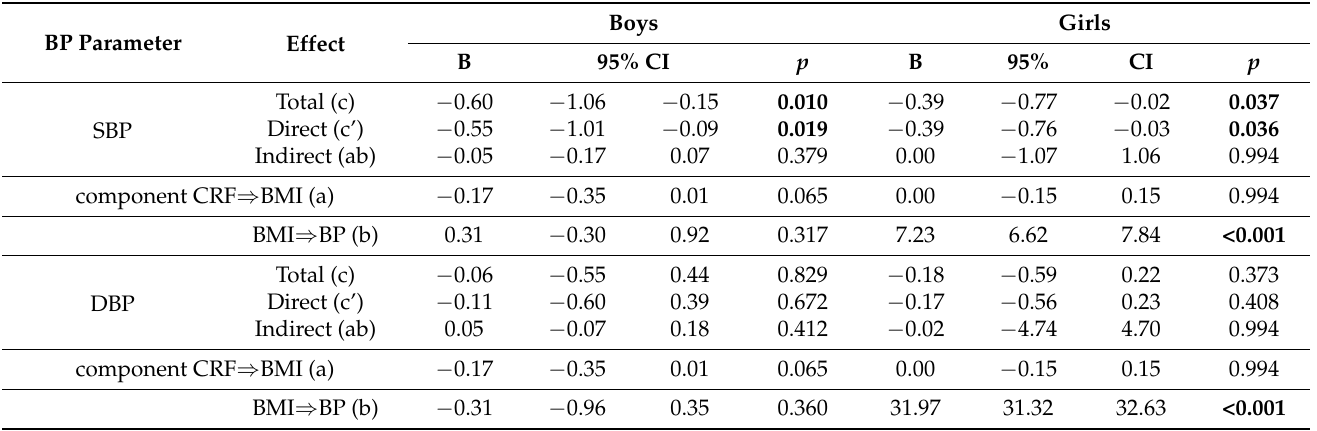
Table 5. The mediation effects of the baseline BMI: total (path c), direct (path c’), and indirect (ab) with its components (paths a and